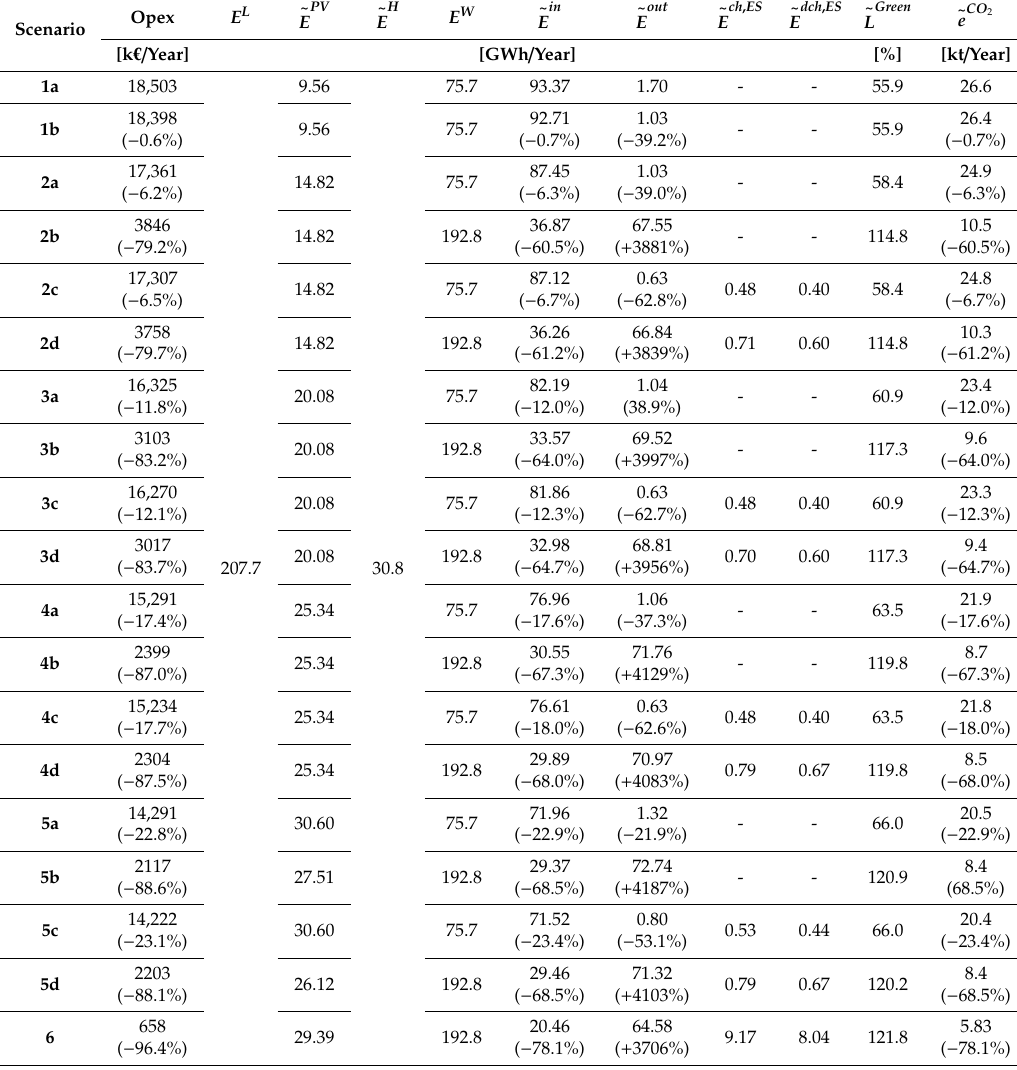
Table 6. Optimal operational